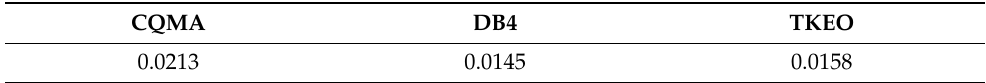
Figure 13. Comparison chart of the envelope spectrum results of three methods: CQMA, DB4, and TKEO. ( a ) CQMA, ( b ) DB4 wavelet, and ( c ) TKEO. Table 8. Characteristic frequency intensity Table 7. PMGI values of different methods.